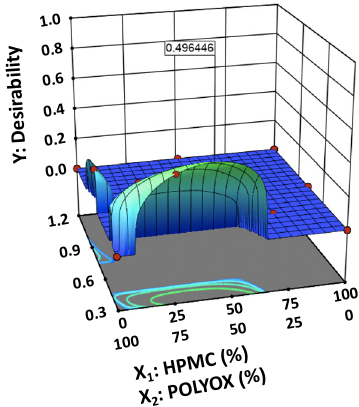
Figure 4. Desirability plot through numerical optimization.